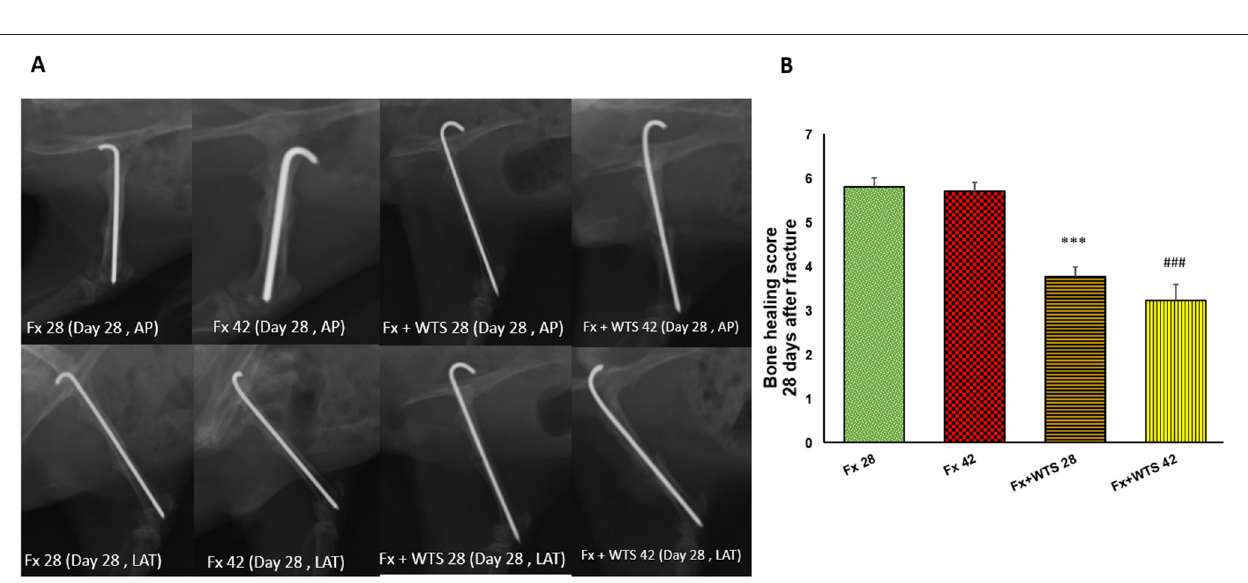
Frontiers in Surgery |